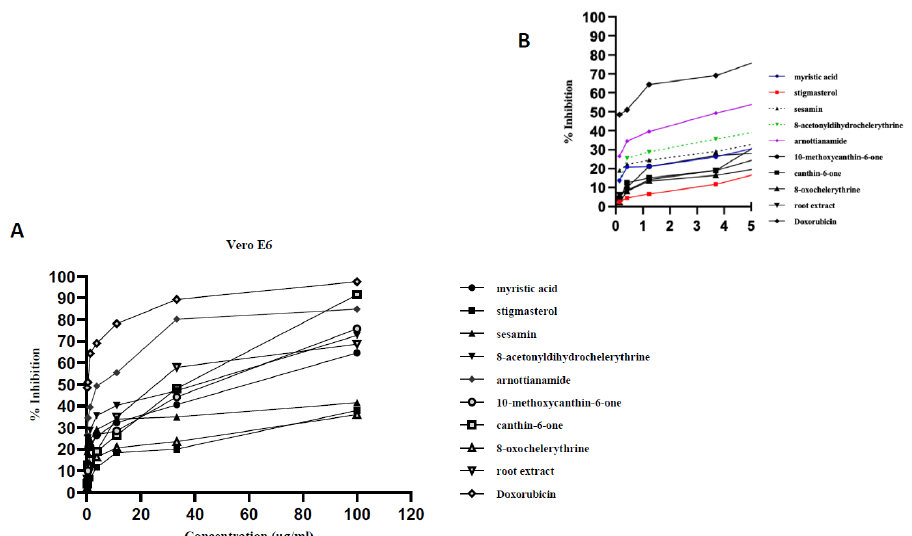
Figure 4. Antiproliferative activity of the tested samples against the normal cell line (Vero E6). Antiproliferative activity of the tested samples against various cancer cell lines recoded as % growth inhibition. (A) Biphasic growth curve of dose-dependent anti-proliferation effects: 0–100 µg/mL. (B) Effect of test samples at low concentrations: 0–5 µg/mL.